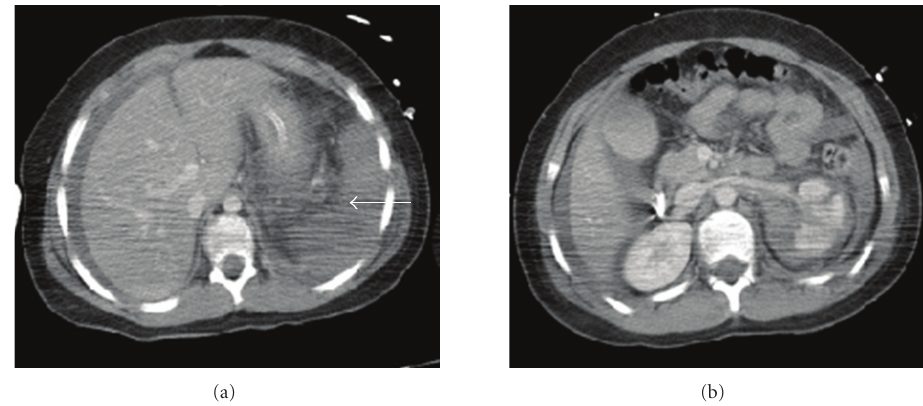
Figure 2: Followup CT scan of the abdomen in portal venous phase shows relative hypodensity of the spleen (white arrow), increase in intraperitoneal fluid, and unchanged appearance of left kidney.